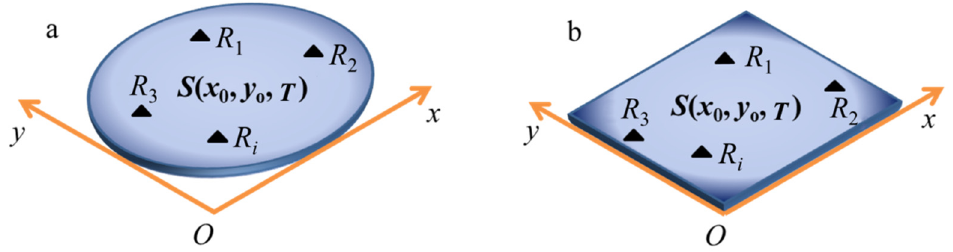
Figure 1. Heat sources in circular and quadrate plates with the adiabatic boundary and displacement components of 0: ( a ) the circular plate; and ( b ) the quadrate plate.